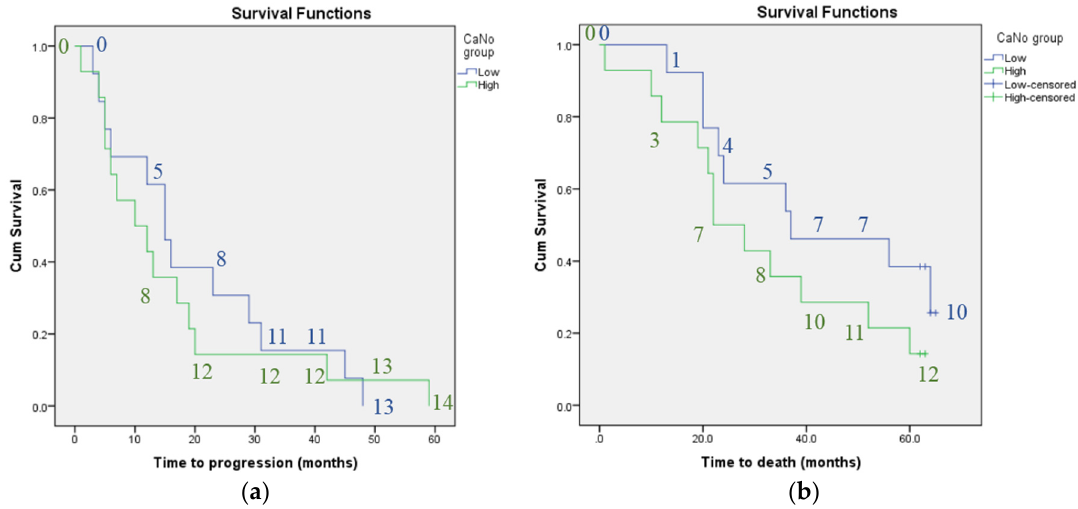
Figure 2. Kaplan ‐ meier curves: survival in terms of: ( a ) disease progression and ( b ) mortality according to baseline CANO; Kaplan ‐ meier curves showing a non ‐ significant trend towards shorter survival as measured by progression of lung disease or mortality in patients with high versus low baseline CANO; Key: low = baseline CANO less than group median; high = baseline CANO greater than group median. No. of patients in low CANO group = 13; no. of patients in high CANO group = 14. The numbers on the graphs indicate the number of individuals classified as having progressive disease or who had died at each 10-month interval for each subgroup.